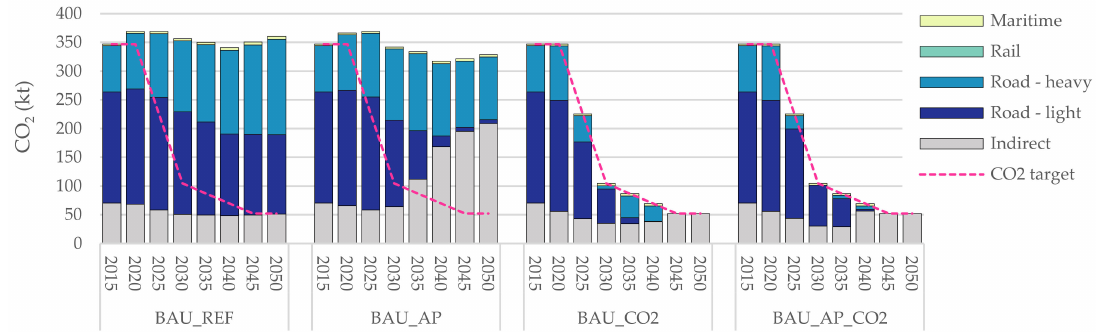
Figure 6. Total upstream and by-mode tailpipe CO 2 emissions in the Business-as-usual (BAU) scenarios (kt). Note : Road—heavy = buses, MGVs and HGVs; Road—light = cars and LCVs.